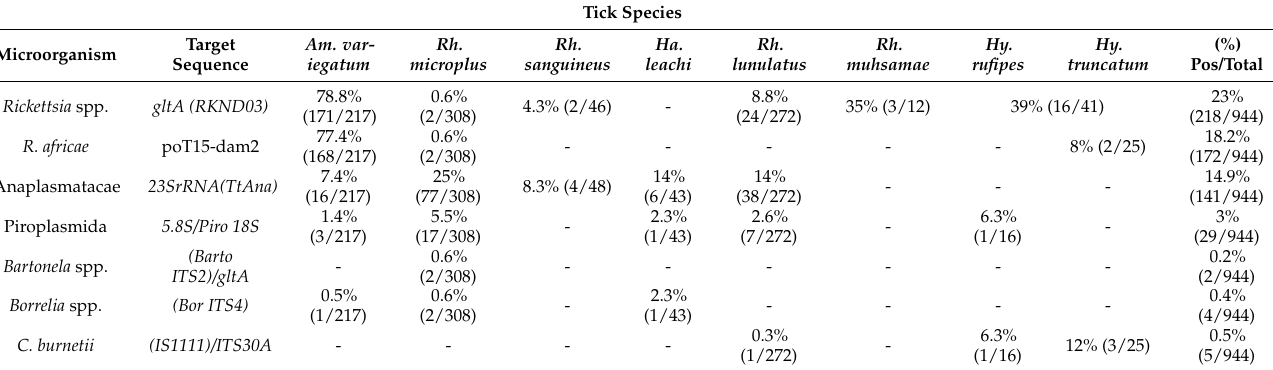
Table 3. Percentage of positive tick species by quantitative real-time